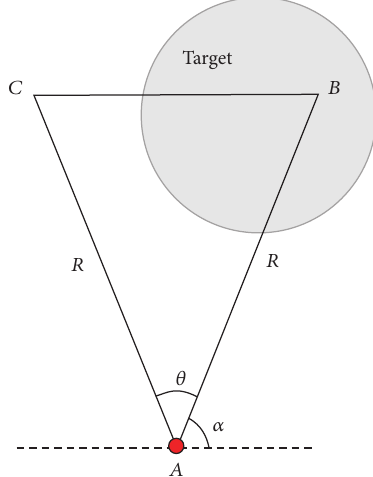
Figure 1: Field of View of a visual